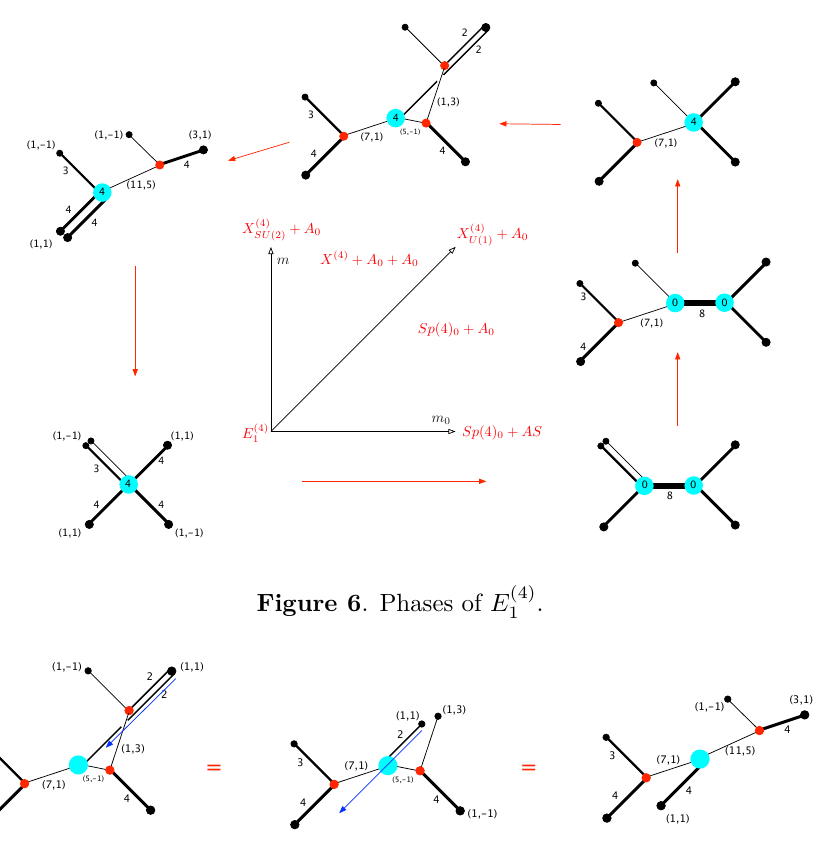
Figure 7 . Equivalent webs for X (4) + A 0 + A 0